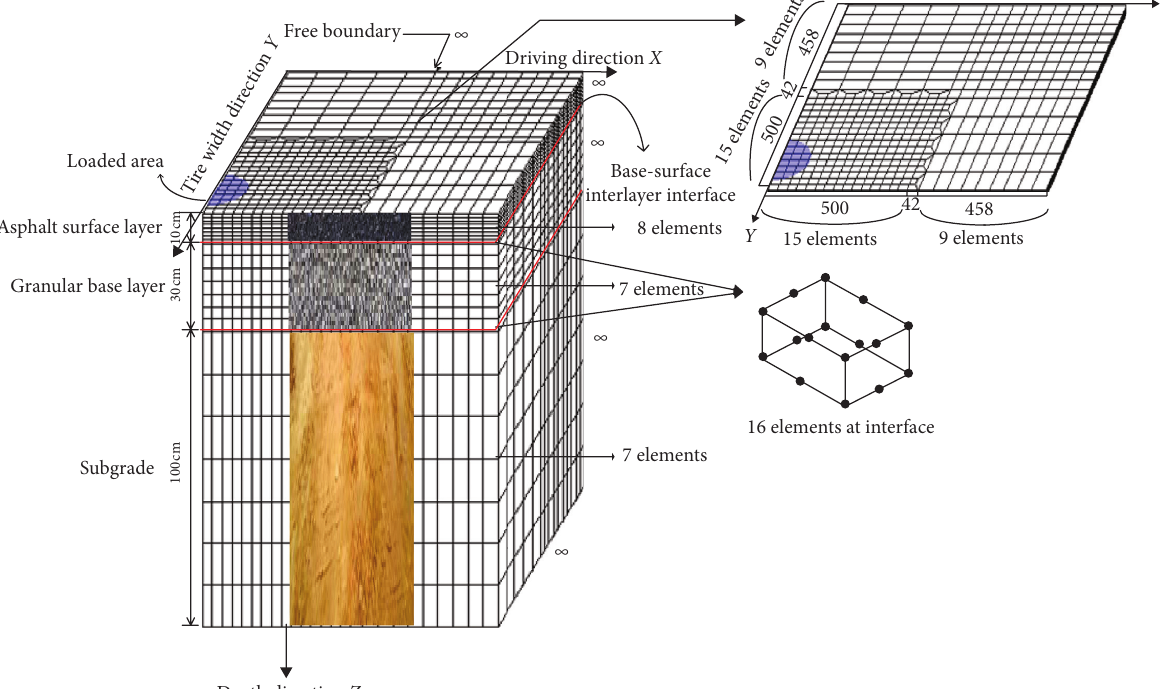
Figure 5: Pavement structure and finite element meshing of